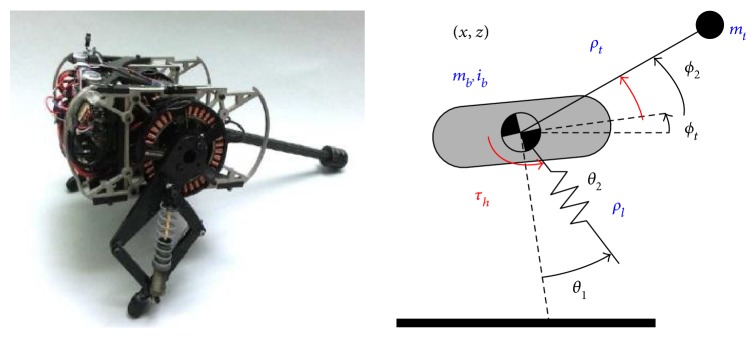
Jerboa robot with a two-DOF tail [77].